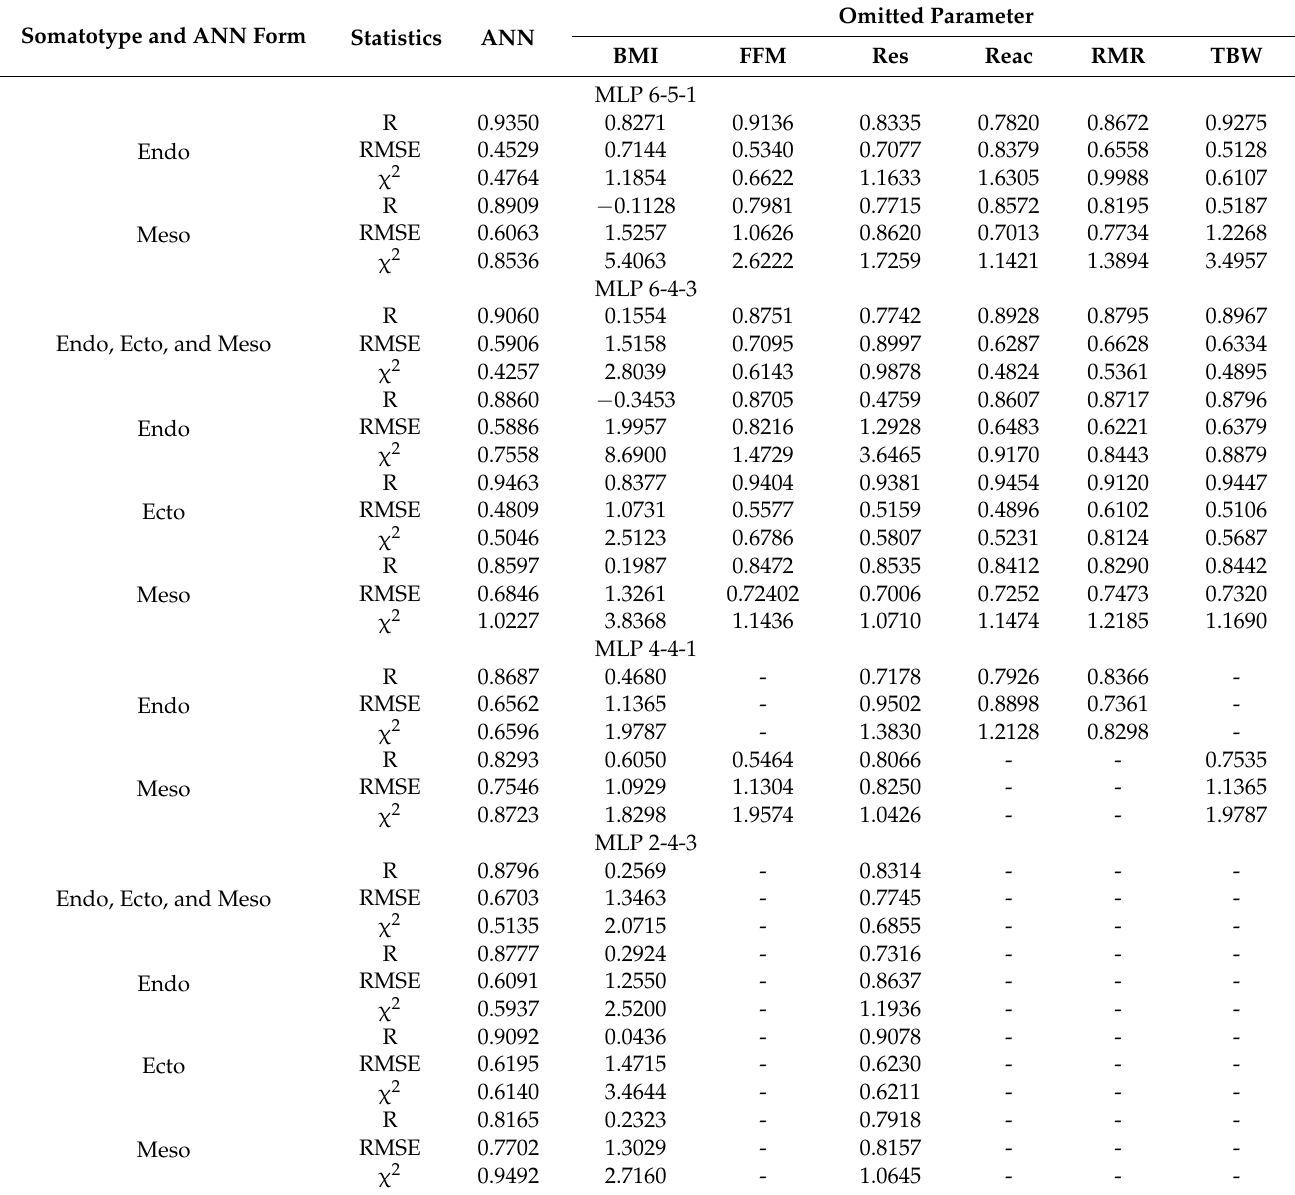
Table 2. Results of statistical analyses on the modelling of somatotypes and sensitivity analysis. Somatotype and ANN